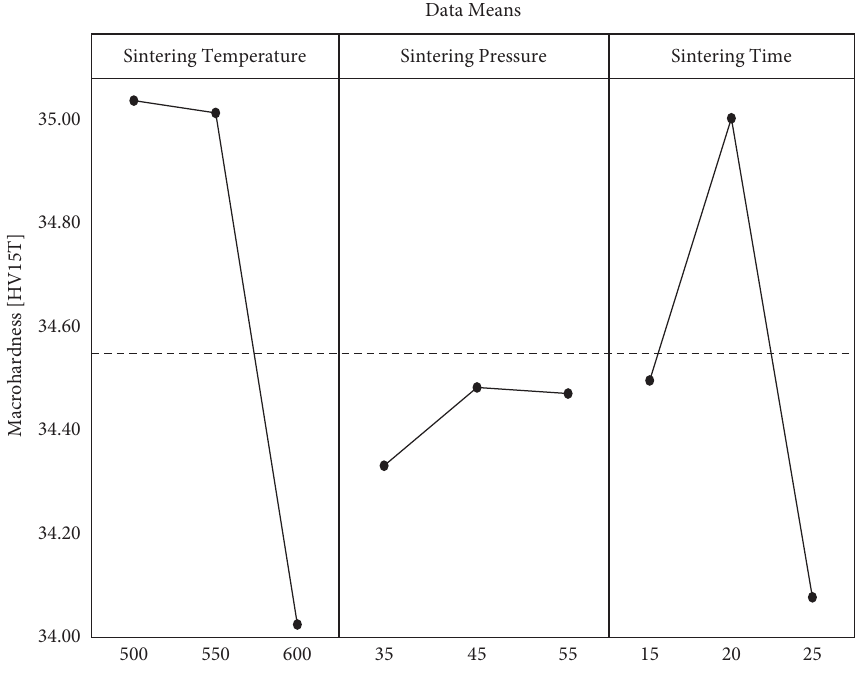
Figure 6: Efect of processing parameters on S/N ratio of